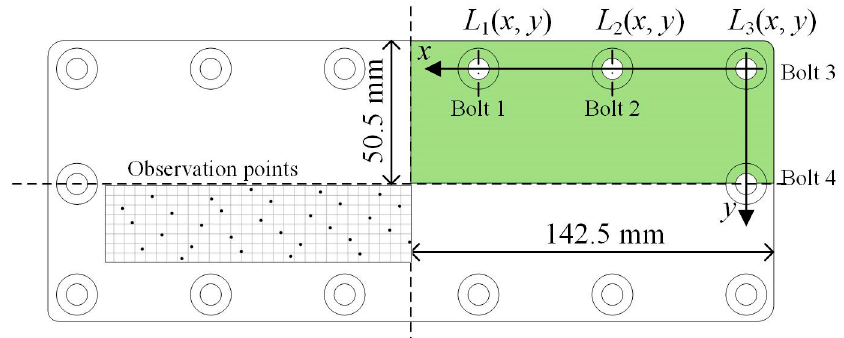
Figure 9. Schematic of the structure design of fuel cell packing.